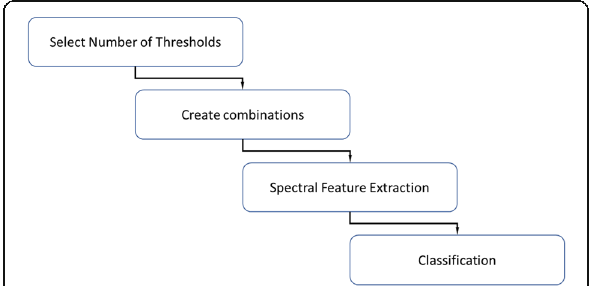
Fig. 2 Flowchart of the methodology followed in this